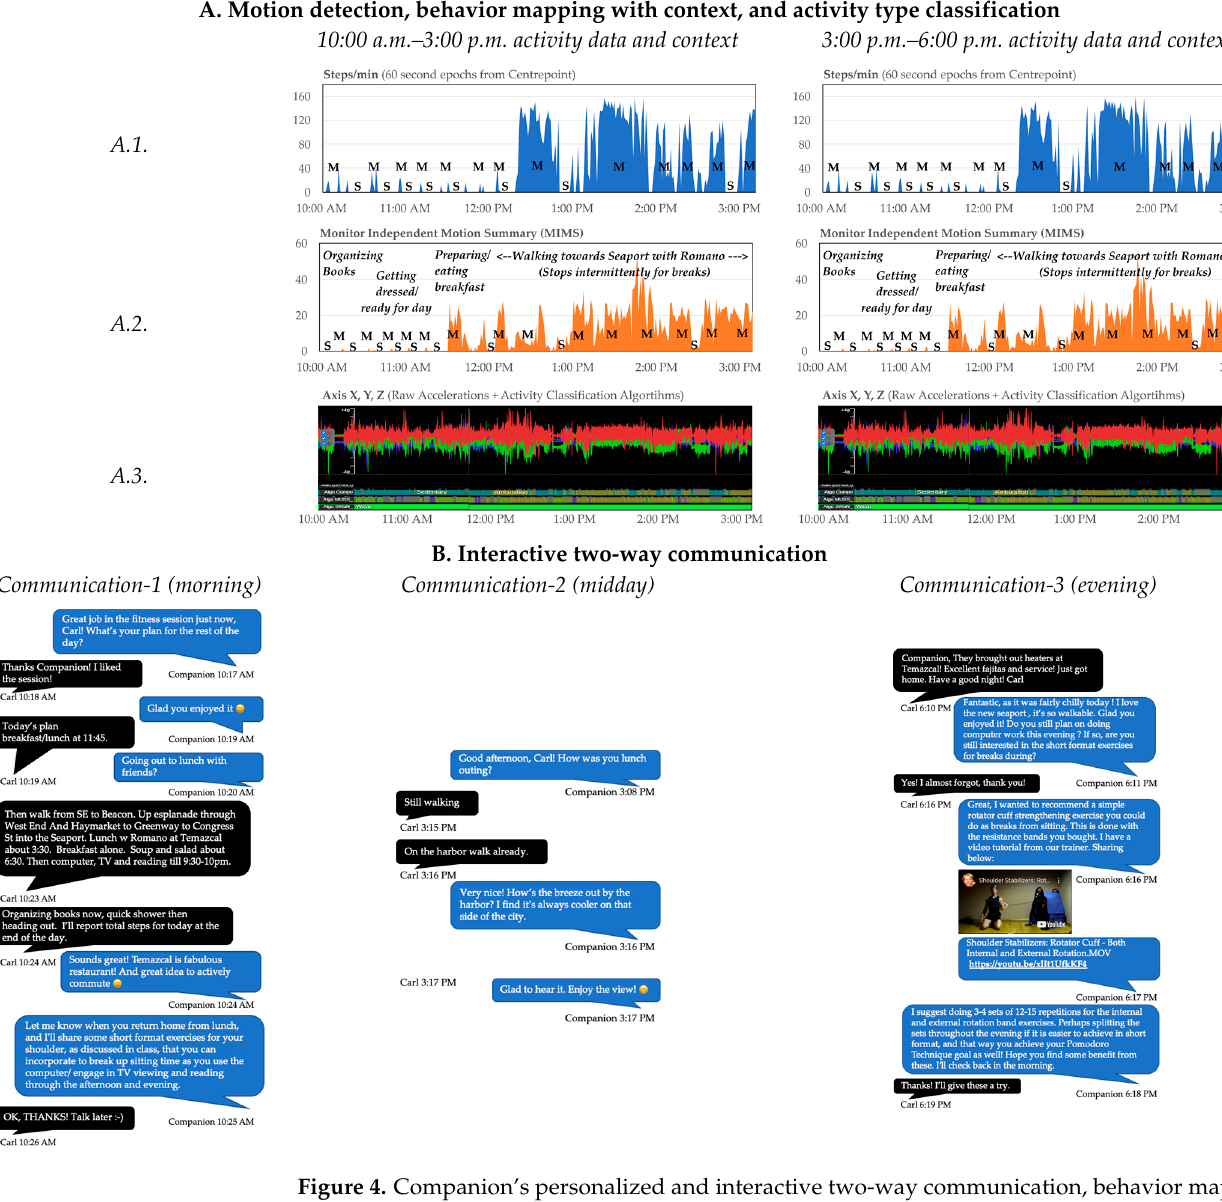
Figure 3. SWaN and MUSS algorithm output merging scheme for generating composite prediction labels. Algorithms outputs are first filtered by SWaN’s non-wear, sleep, and wear classifications. SWaN’s wear event classifications are assigned corresponding to MUSS classifications with lying, sitting movement, and non-wear, which are grouped under a composite “sedentary” label.